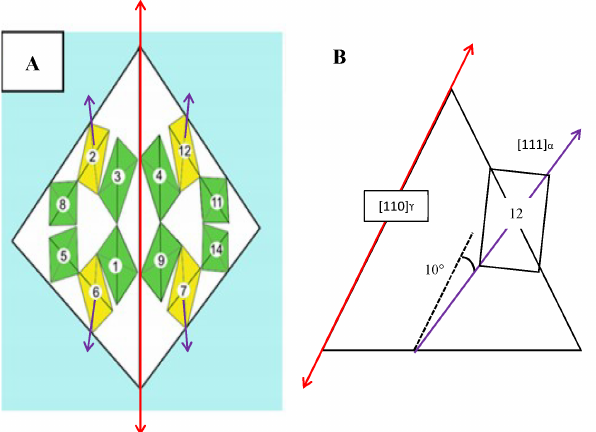
Figure 6. Empirical criterion for variant selection. ( A ) Plate group represented in 3D on two { 111 } γ planes. Illustration adapted from ref. [20]. ( B ) Triangle representing the ( 1¯11 ) γ plane and rectangle representing in 2D the ( 1¯10 ) α of variant 12. In purple, the [ 111 ] α that clusters about the [ 110 ] γ marked in